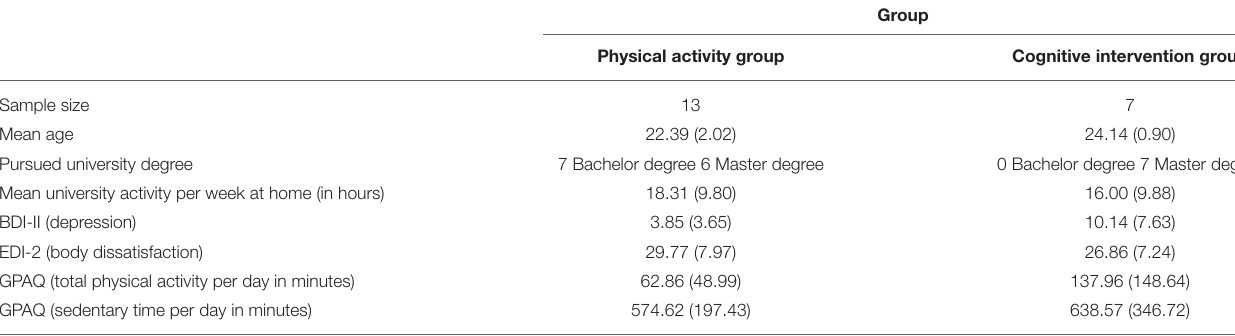
TABLE 1 | Baseline self-report data of participants in dependence of group with means and standard